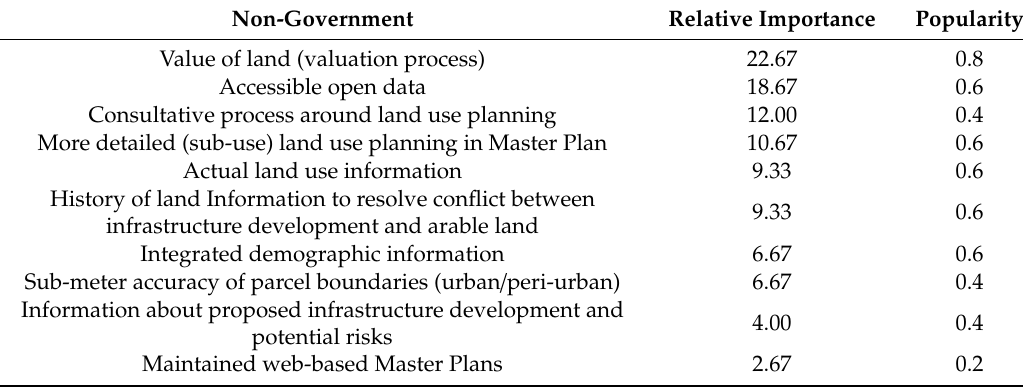
Table 7. Land information needs identified by non-government